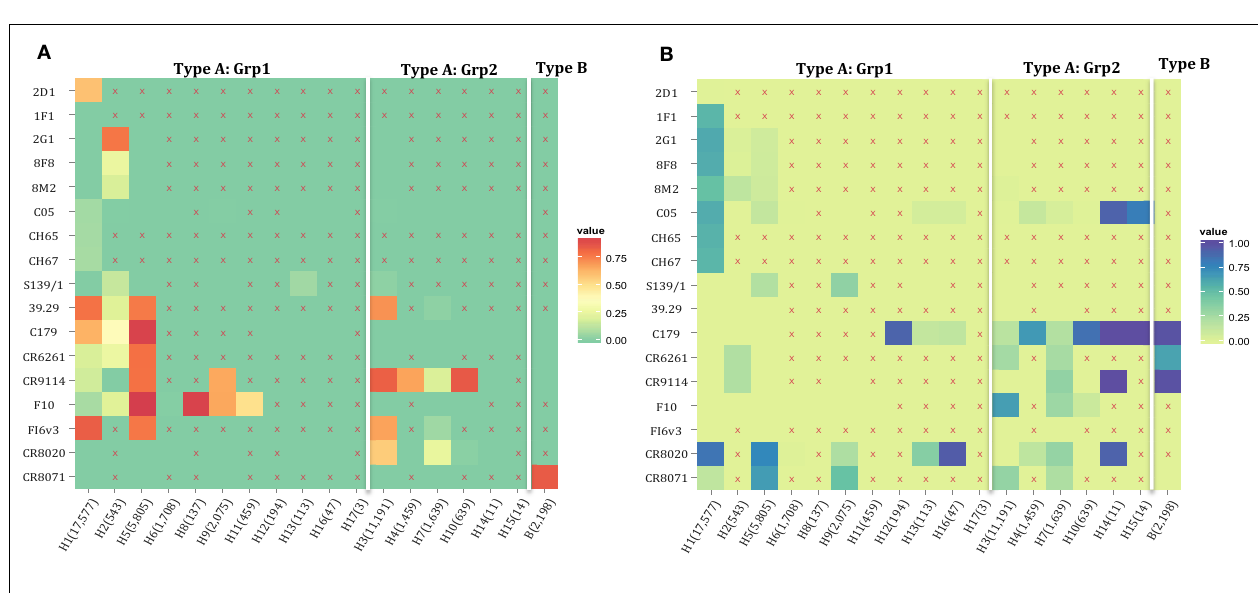
FIGURE 8 |The neutralized and escape motif coverage on each subtype within FLUKB of neutralizing antibodies .The heat map of (A) neutralized and (B) escape coverage are shown. Each cell on the grid represents coverage for a specific antibody (row name) on specific subtype (column name).The subtypes were sorted from Grp1 and Grp2 in influenza A virus,